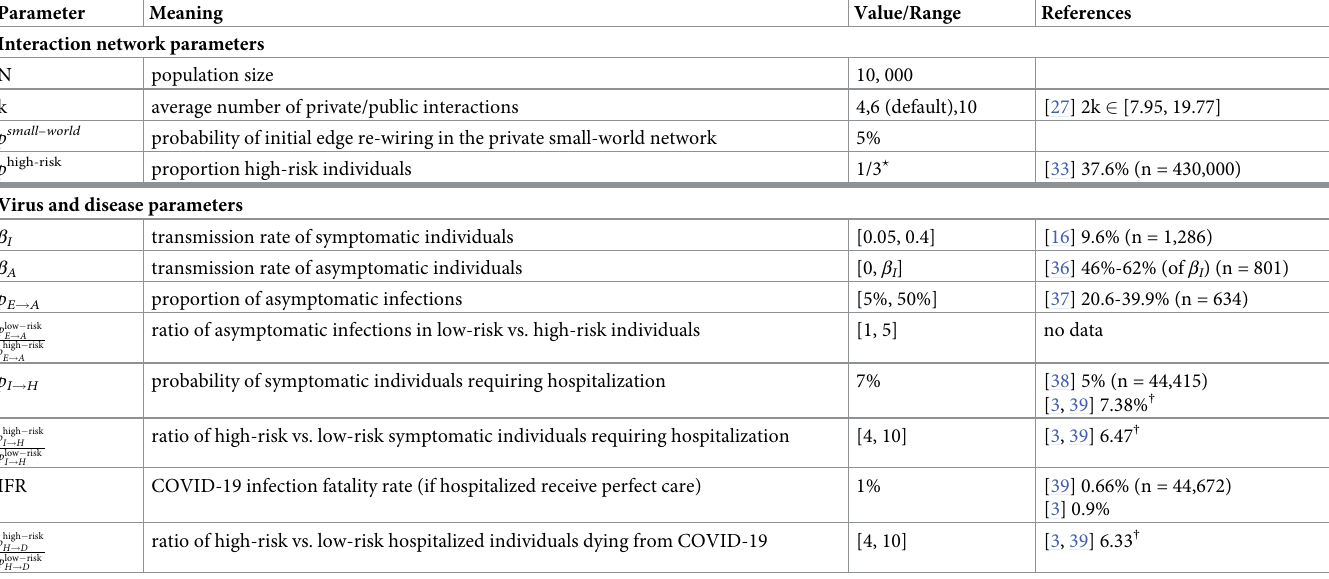
Table 1. Model parameters and the value or range (sampled uniformly) used in this study (third columns). Estimates from the literature with respective sample sizes ( n ) are reported where applicable and available (last column). ? [33] considers only the U.S. adult population. Adding 0-17 year-olds with an assumed high-risk rate of 21.2% (the estimate for 18-59yr olds) and projected 2020 US census data [34] yields an overall high-risk estimate of around 1/3. † derived from Table 1 in [3] and projected 2020 US census data [34].